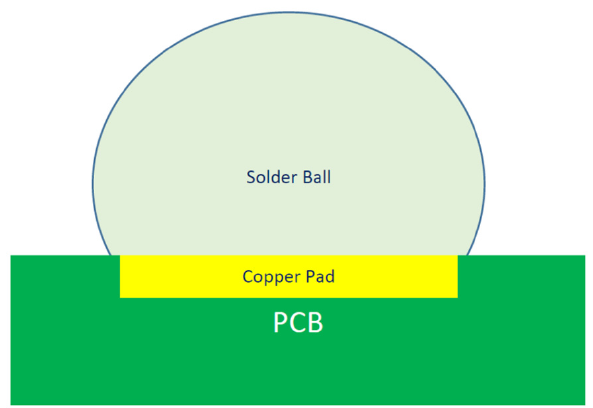
Figure 1. Test vehicle design.